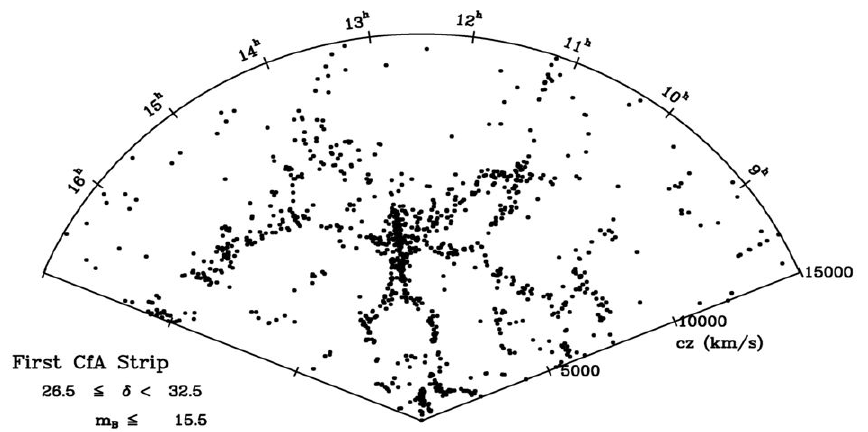
Figure 2. This is the all famous map of the first Center for Astrophysics Redshift Survey (CfA). It was clear from it that the galaxy distribution at large scale was not random. This map had a great impact on the scientific community, not just in that of astronomers and cosmologists. Galaxies in the map seem to concentrate on bubble like surfaces while there appear to be very large empty regions, or “voids.” Some impacting structures, as the man and the finger of God are also very apparent here. V. de Lapparent, M. Geller and J.P. Huchra, Astrophys. J. Lett. 302 , L1 (1986) Smithsonian Astrophysical